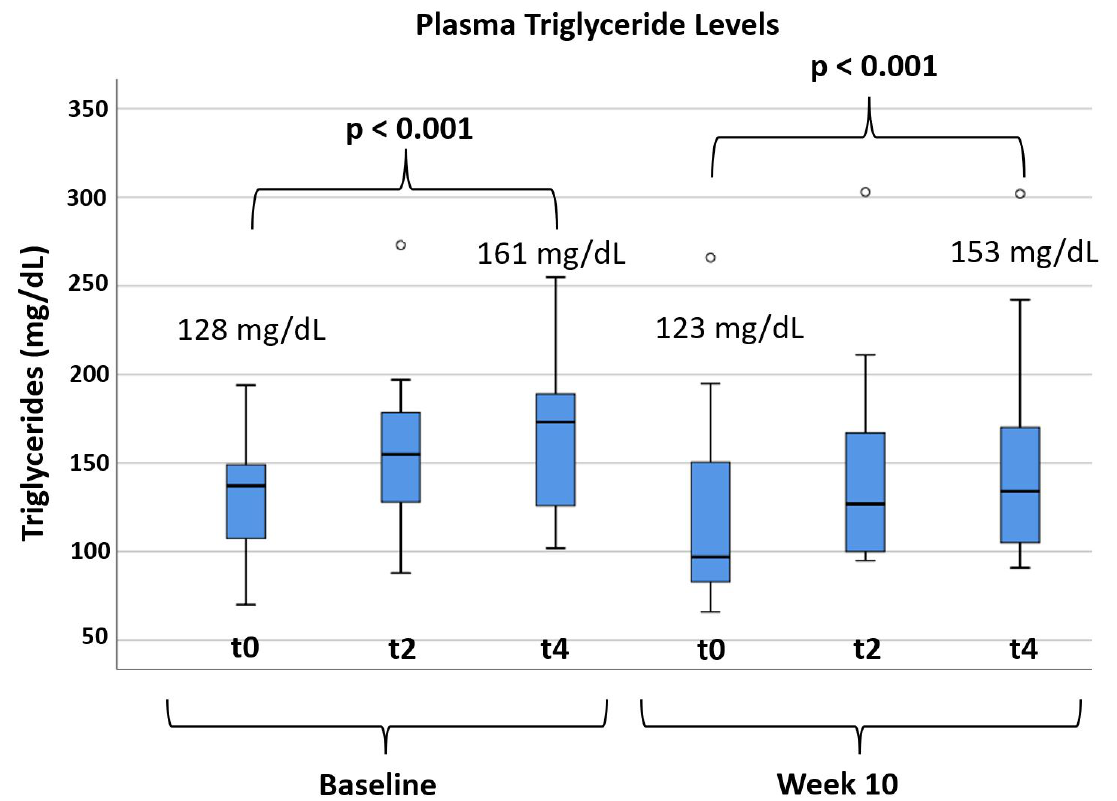
Figure 1. Fat-tolerance test results with Lipotest ® meal at baseline and after 10 weeks of treatment with alirocumab. Legend: Triglyceride plasma levels at baseline and after 10 weeks of alirocumab treatment, before Lipotest ® meal consumption (t0), at 2 h (t2), and 4 h (t4). Among the trial completion population, 14 patients participated in the per-protocol optional fat-tolerance assessment ( n = 14). The small circles at the upper part of the figure identify outlier measurements. Outliers are defined as values between 1.5× and 3× interquartile ranges from the end of a box. Paired-samples t -test with two-sided p -value was performed.